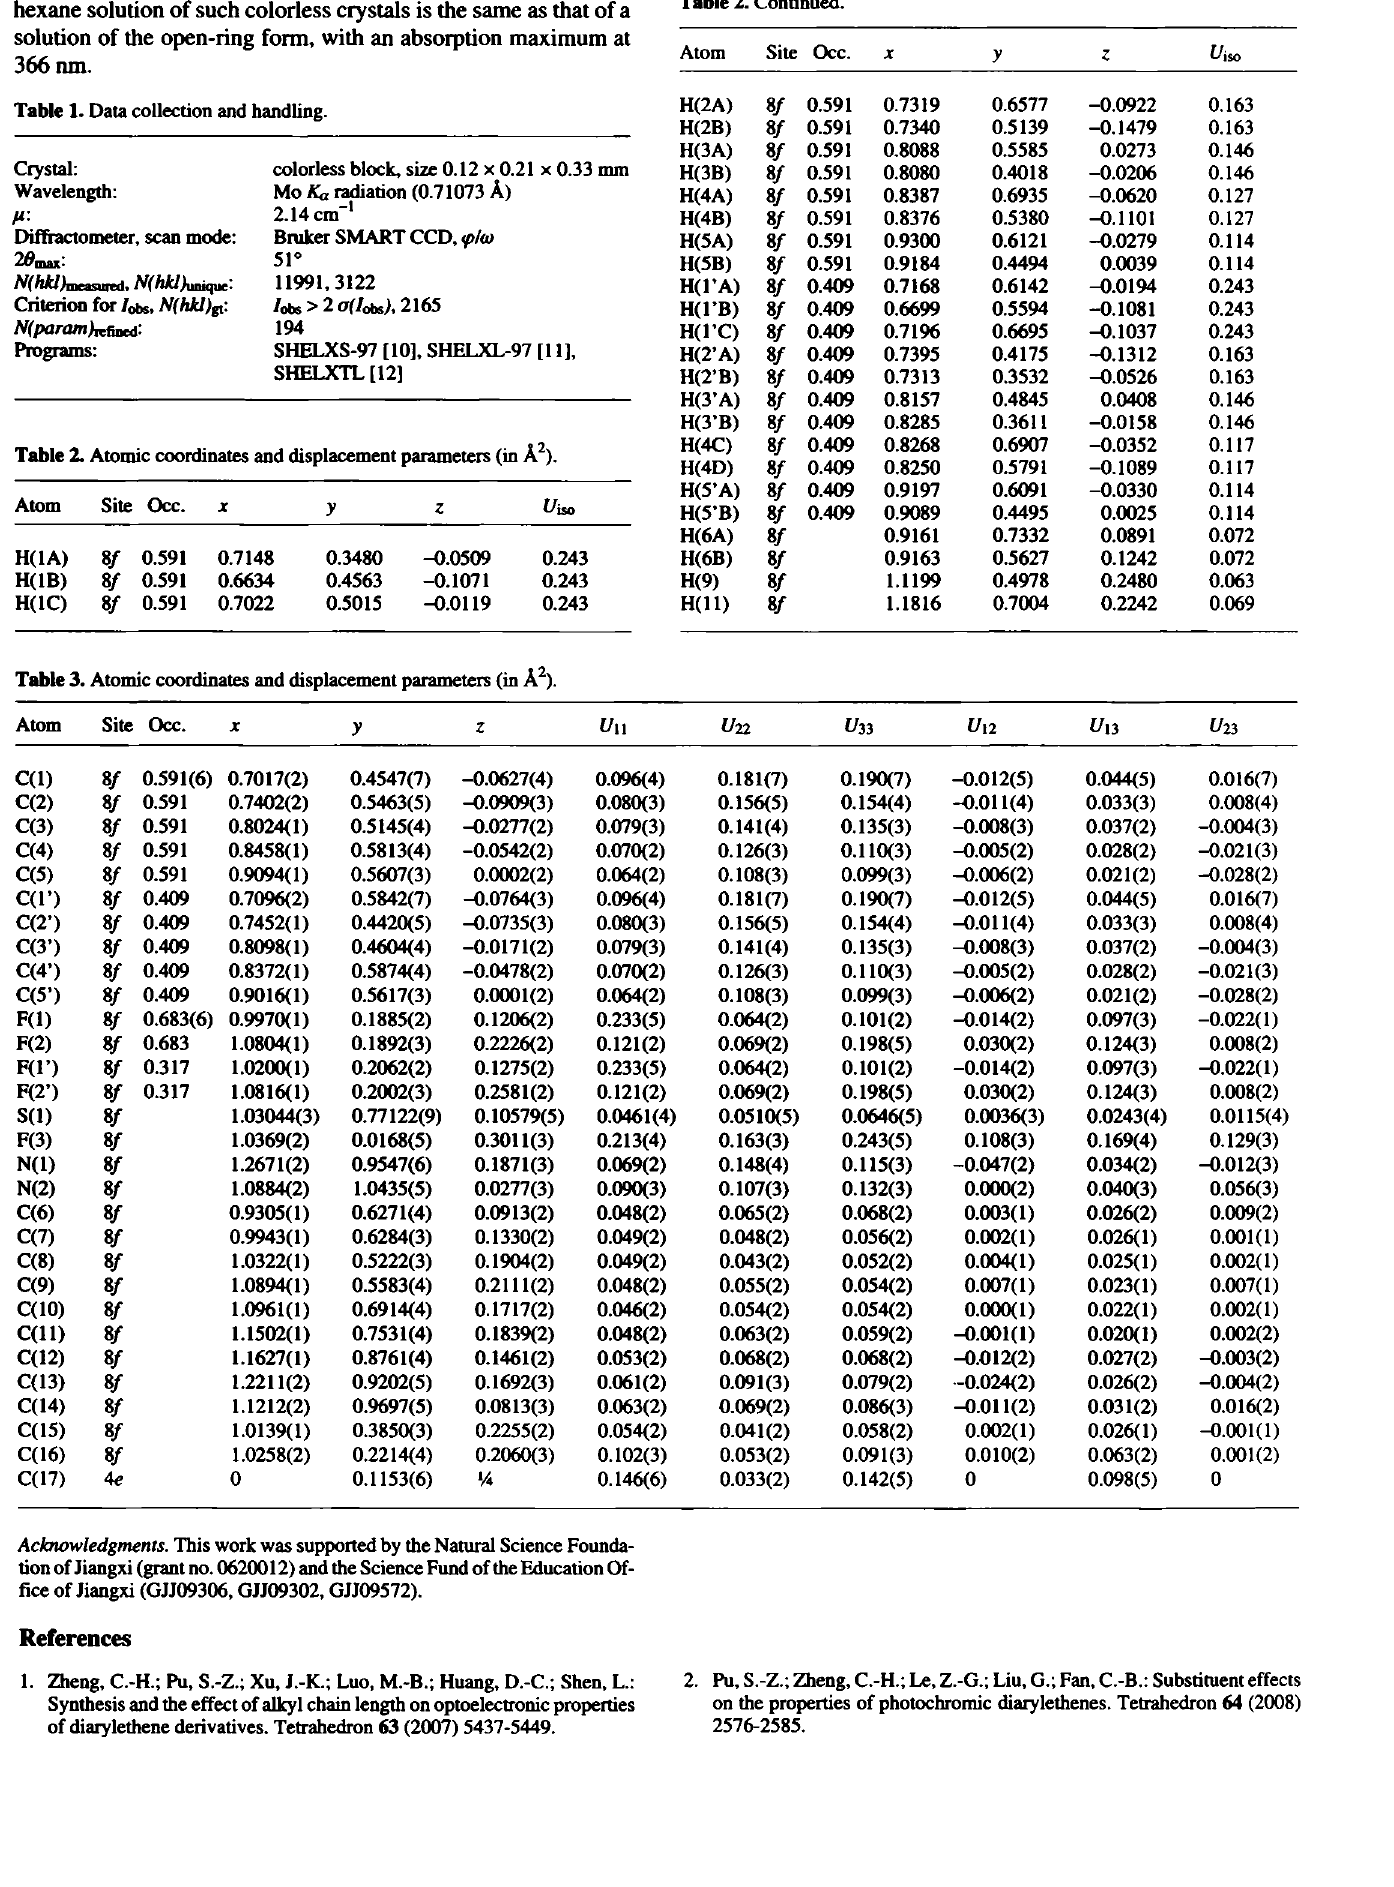
Table 3. Atomic coordinates and displacement parameters (in Â 2